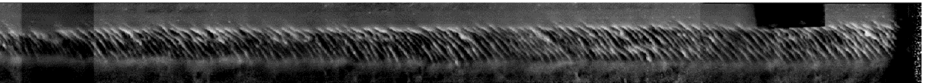
Figure 9. Panoramic phase image computed from five measurements for a whole length of 250 mm.